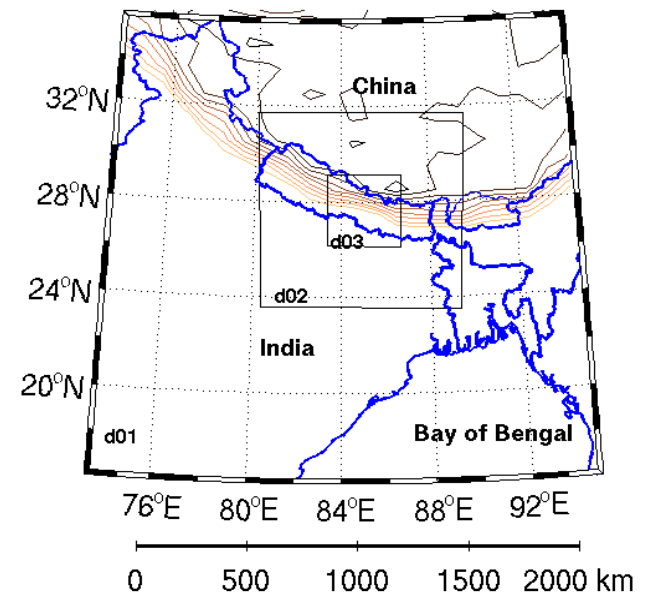
Figure 1. Domains used for WRF simulation with horizontal grid resolution 27 km (domain 1), 9 km (domain 2) and 3 km (domain 3) centered over central Nepal (26.34° N, 83.12° E) and the model is set to 40 vertical levels. Elevation contours are plotted at intervals of 500 m between 1500 and 8000 m